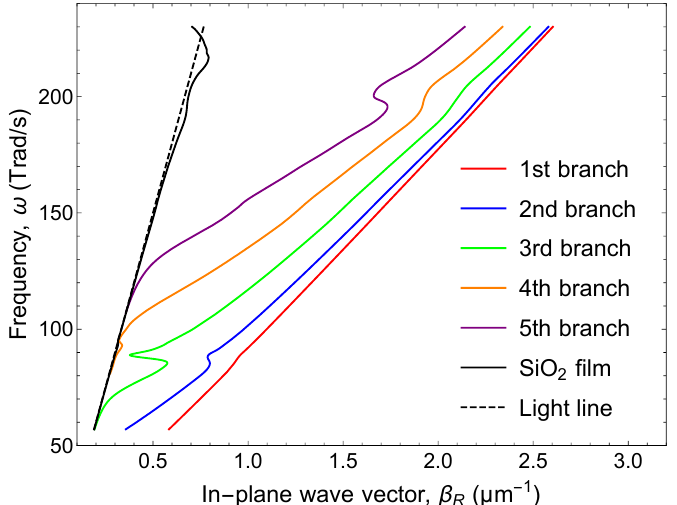
Figure 3. Dispersion relations of SPhPs propagating along a SiO 2 (1 µ m)/Si (10 µ m)/SiO 2 (1 µ m) structure.